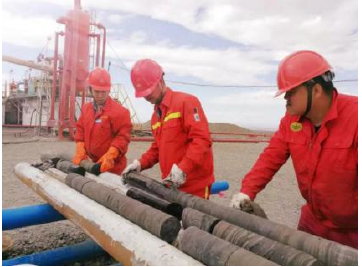
Figure 1. On-site sampling photos.